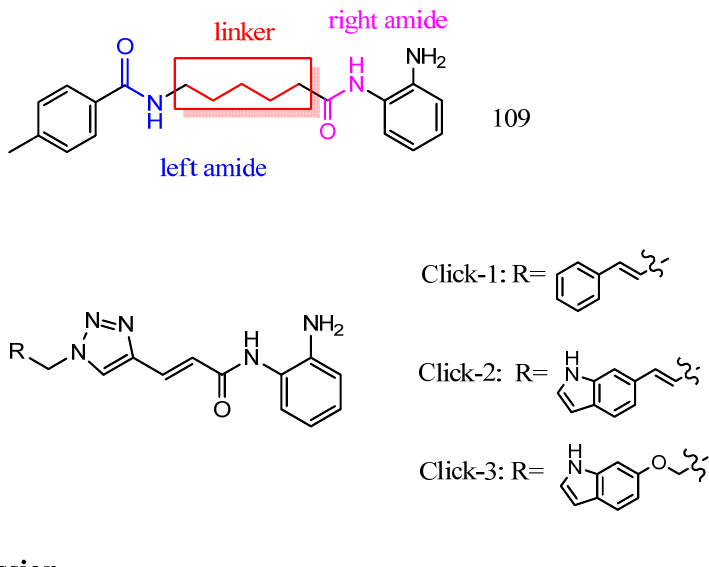
Figure 2. Structures of 109 and click